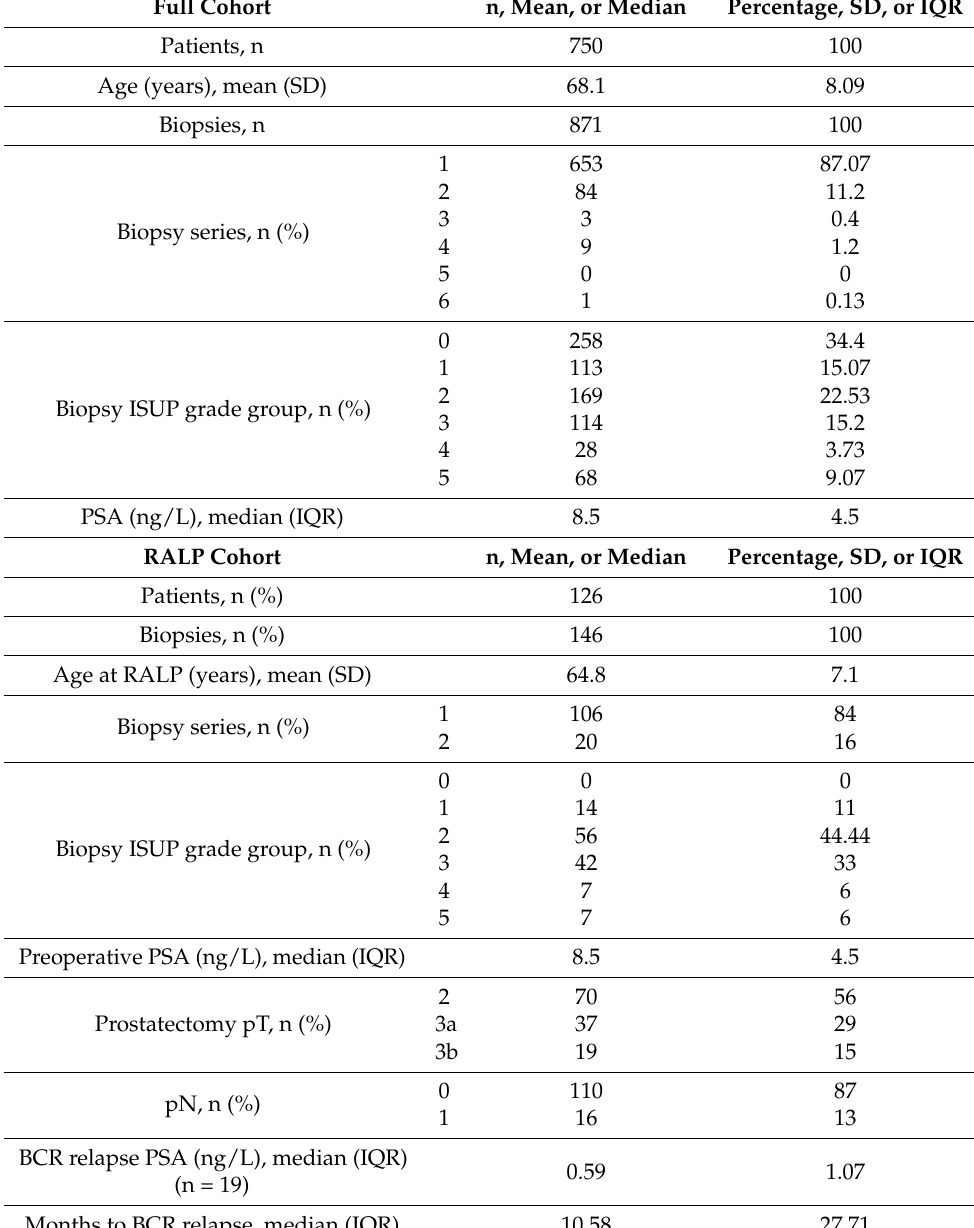
Table 2. Characteristics of the men diagnosed with prostate cancer and the subcohort that underwent surgical